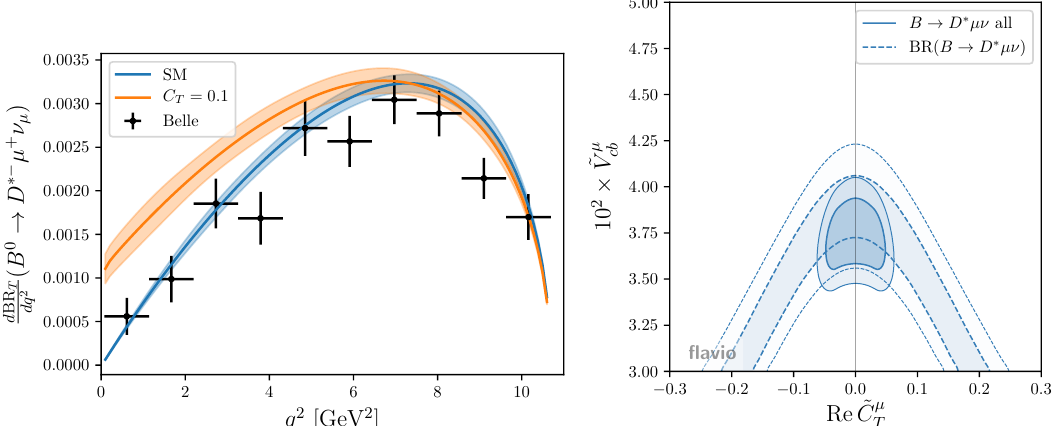
Figure 7 . Left: prediction for the transverse di(cid:11)erential B D (cid:3) (cid:22)(cid:23) branching ratio in the SM ! (blue band) and a scenario with new physics in C (cid:22) (orange band) vs. the Belle measurement, T demonstrating the di(cid:11)erent endpoint behaviour at maximum recoil ( q 2 = 0). Both scenarios predict the same total B D (cid:3) (cid:22)(cid:23) branching ratio. Right: comparison of the constraint on the tensor ! coe(cid:14)cient ~ C (cid:22) vs. ~ V (cid:22) from the total B D (cid:3) (cid:22)(cid:23) branching ratio measurements only (dashed) and T cb ! using all B D (cid:3) (cid:22)(cid:23) measurements !